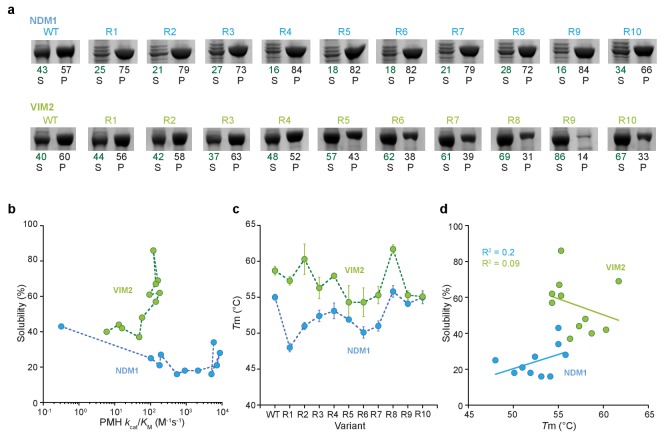
Solubility and melting temperature of variants.(A) SDS-PAGE images of protein expression in the supernatant (S) and pellet (P) fractions of the cell lysate. The numbers below indicate the percentage of protein in the soluble and insoluble fraction, which is calculated from the relative intensities of the supernatant and pellet bands. (B) Correlation between solubility and catalytic efficiency along the evolutionary trajectories. (C) Melting temperature (Tm) of all variants along the evolutionary trajectory as calculated from the midpoint of the denaturation curve in a thermal shift assay. Error bars represent standard deviation from three independent assays. (D) Correlation between solubility and melting temperature (Tm) of NDM1 and VIM2 variants.